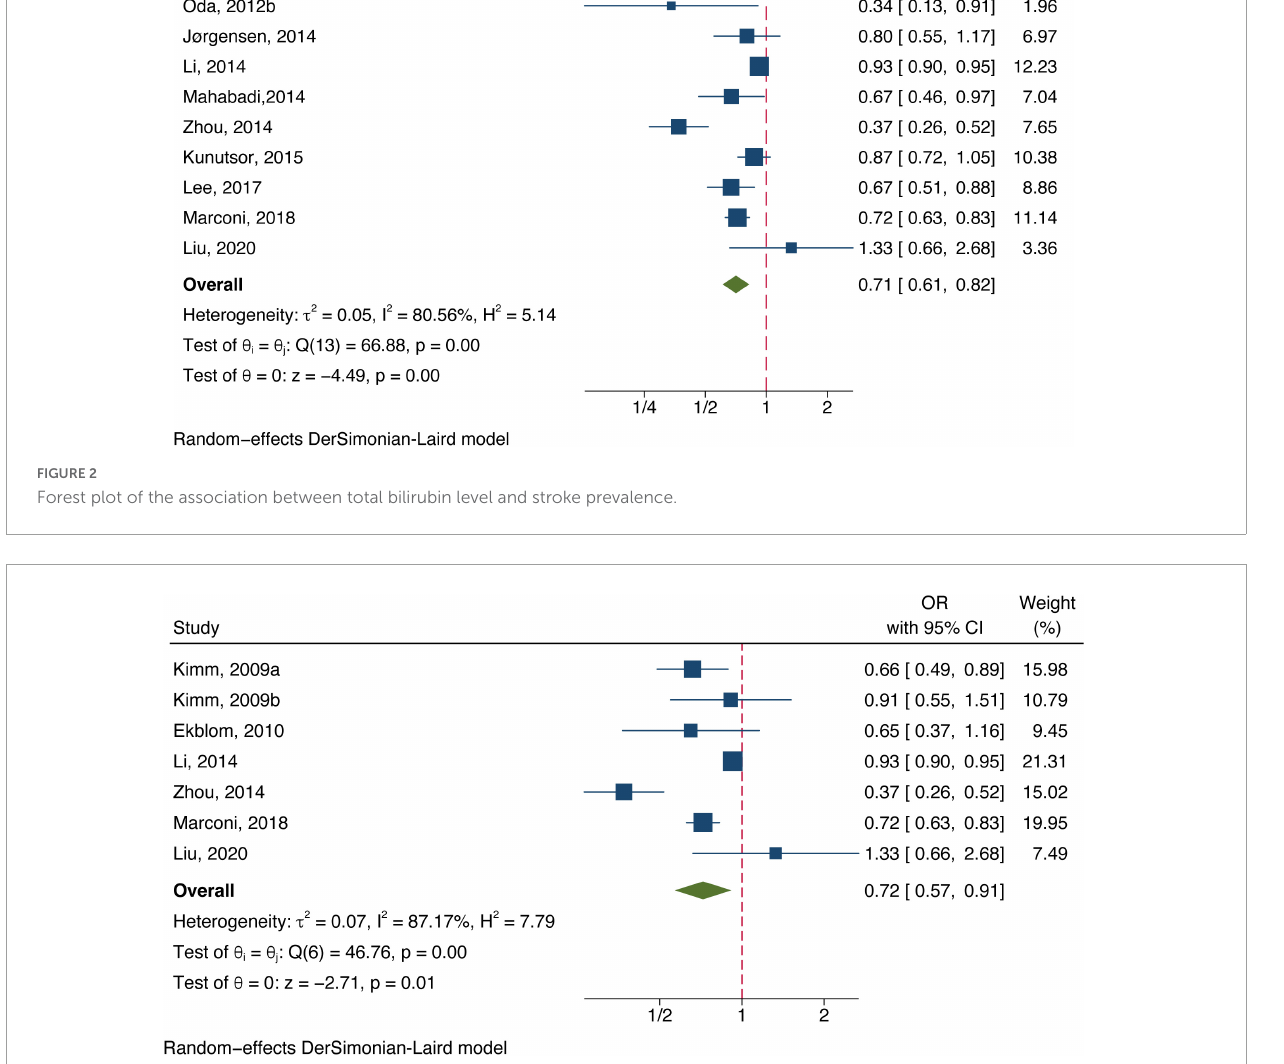
FIGURE3 Forest plot of the association between total bilirubin level and ischemic stroke prevalence.